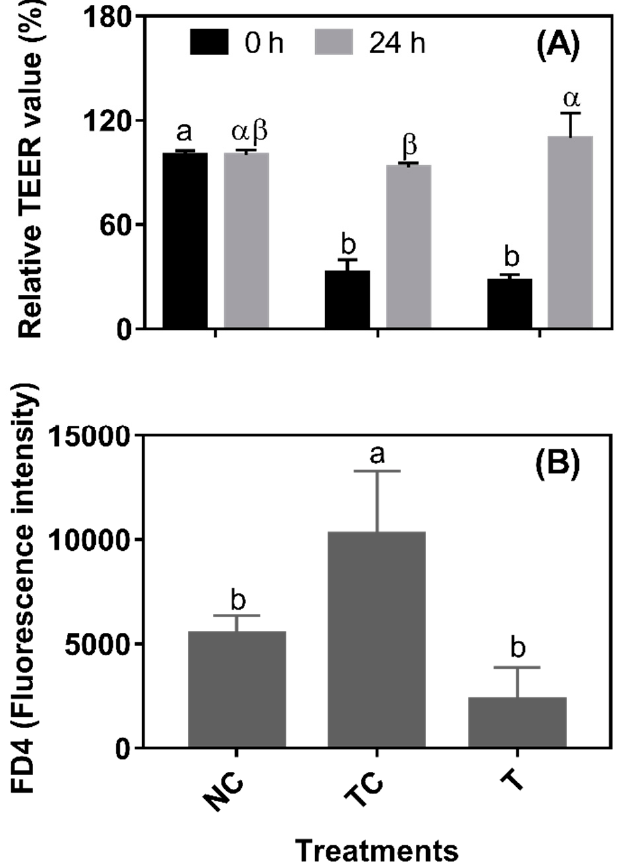
Figure 4. The effect of red-osier dogwood extracts (RDE) on the transepithelial resistance (TEER) ( A ) and permeability ( B ) of Caco-2 cells after H 2 O 2 treatment. NC indicates negative control: cells were cultured with DMEM solution without H 2 O 2 and RDE for 27 h (3 h + 24 h). TC indicates treatment control: cells were cultured with a medium containing 1 mM of H 2 O 2 for 3 h, and then treated with a medium for 24 h. T indicates RDE treatment: cells were cultured with a medium containing 1 mM of H 2 O 2 for 3 h, and then treated with medium containing 100 µg/mL of RDE for 24 h. TEER was measured after H 2 O 2 treatment for 3 h and after RDE treatment for 24 h, respectively. The data were presented as mean ± SD, n = 4. Different lower case letters and Greek letters indicate a significant difference at P < 0.05.